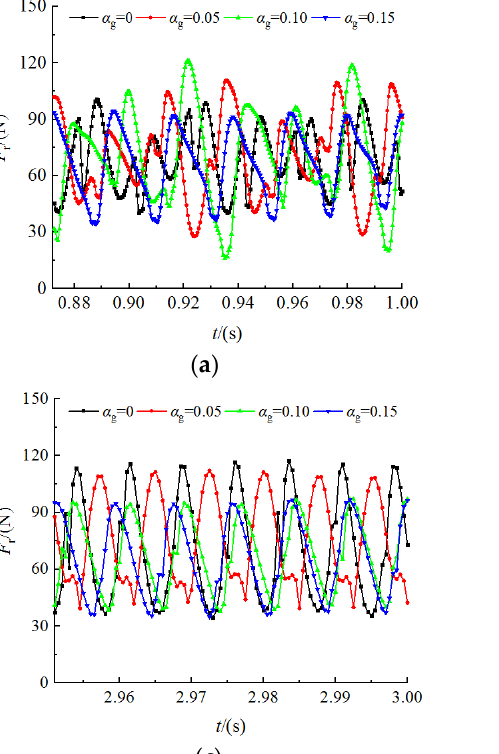
( d ) Figure 11. Vector distribution of radial force during the start-up process at α g = 0.15. ( a ) t = 1 s; ( b ) t = 2 s; ( c ) t = 3 s; ( d ) t = 4 s. To compare the effect of different IGVFs on the radial force time domain of the PAT start-up process, the start-up process has been respectively calculated under four condi- tions of α g = 0, α g = 0.05, α g = 0.10, and α g = 0.15. The time domain characteristic of radial force during the start-up process is shown in Figure 12. The abscissa is a rotation period when α g = 0.15, and the ordinate is the radial force. Due to the lower IGVF, the greater the liquid inlet flow rate, the faster the PAT accelerates during the start-up process. At the same time, the more minor the IGVF, the more the number of radial force fluctuation. At t = 1 s, the time domain distribution of radial force is not uniform under different IGVFs. The amplitude of radial force is the largest under the condition of α g = 0.10. At t = 2 s, the amplitude of radial force under α